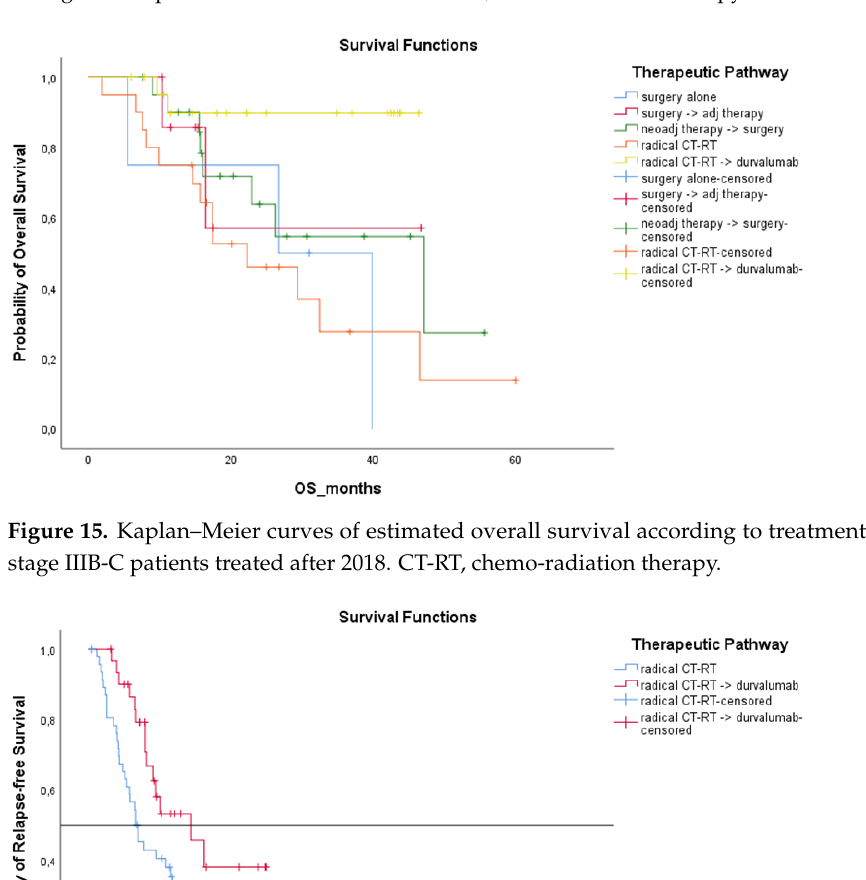
Figure 17. Kaplan–Meier curves of estimated overall survival in the entire population who under- went definitive chemo-radiation therapy according to treatment pathway. CT-RT, chemo-radiation therapy. Table 6. Survival outcomes as per the chemo-radiation treatment pattern. Treatment Modality